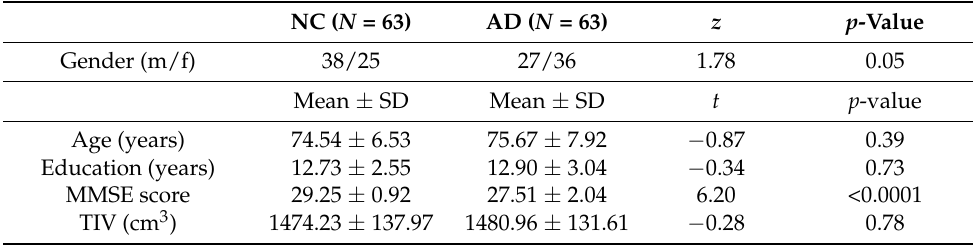
Table 1. Demographic and behavioral measurements; NC: cognitively normal participants; AD: mild cognitive impairment and early Alzheimer’s disease group; MMSE: Mini-Mental State Examination; TIV: total intracranial volume; SD: standard